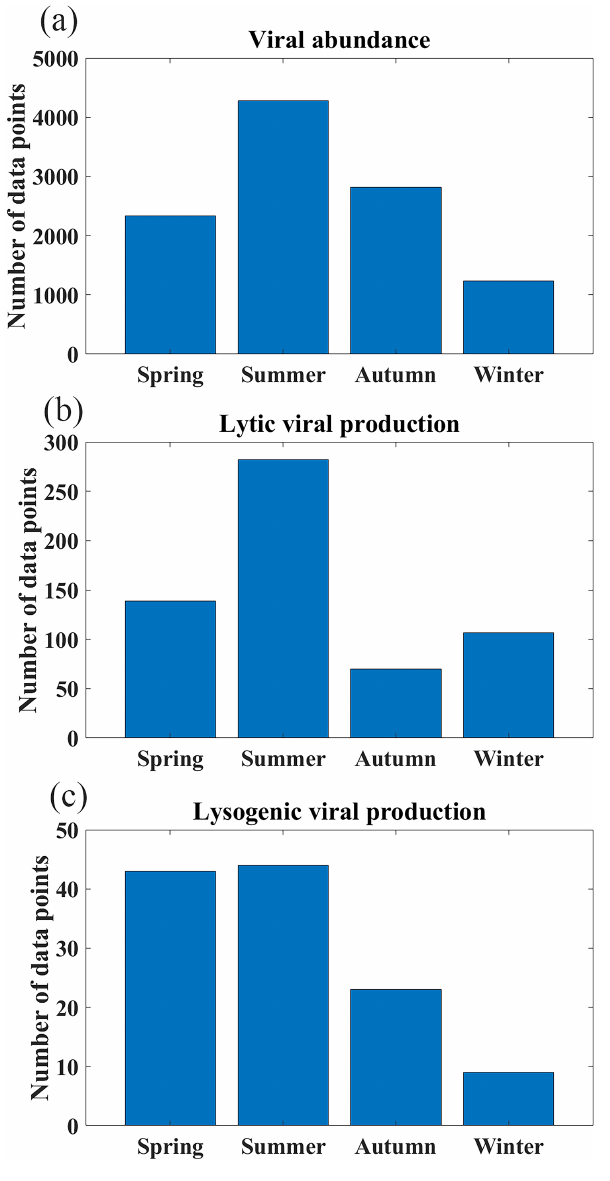
Figure 4. Seasonal distributions of number of samples for (a) viral abundance, (b) lytic viral production and (c) lysogenic viral produc- tion.